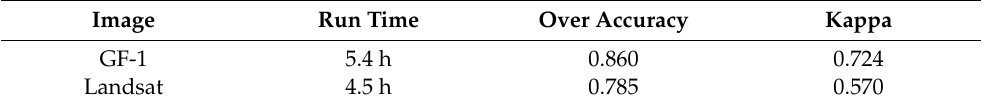
Table 1. Change detection results.